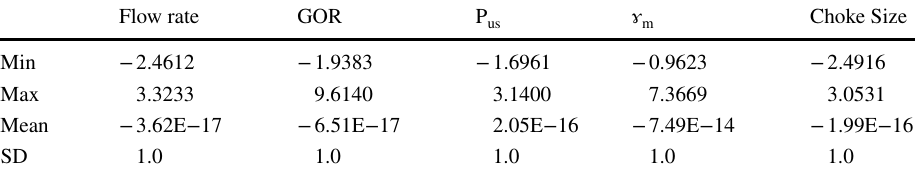
Table 4 Statistical analysis of the data after normalization